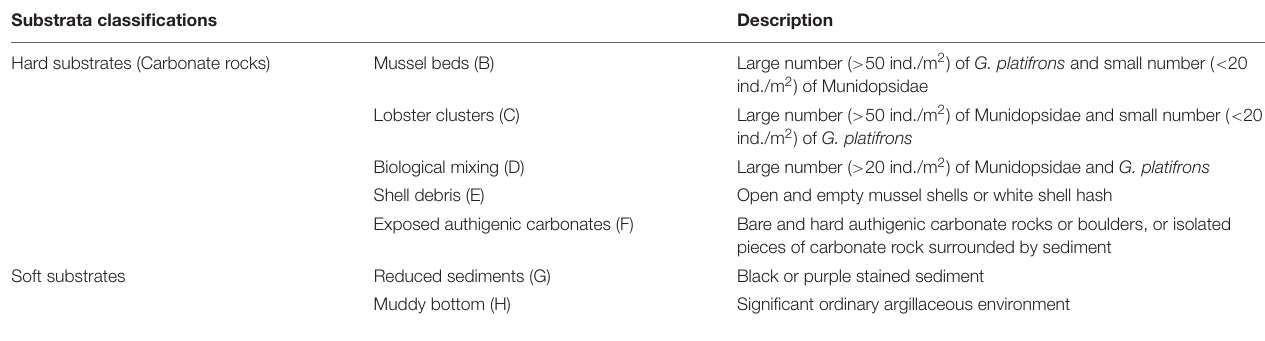
TABLE 1 | Definitions and descriptions of the two main substrates (seven small